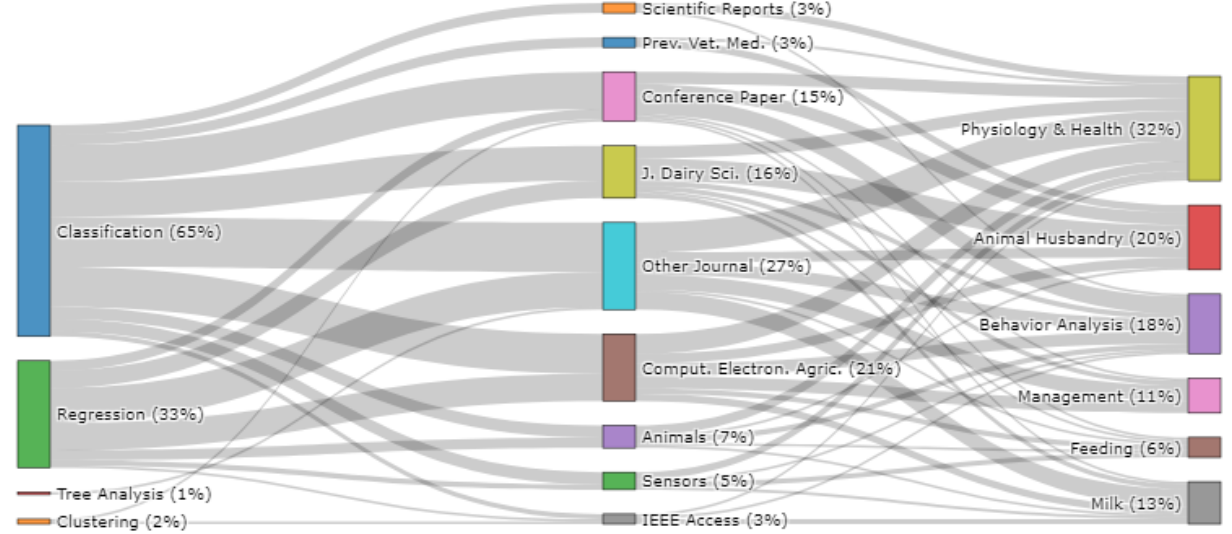
Figure 5. The flow of studies from problem type to publication source to research categories (n = 131).